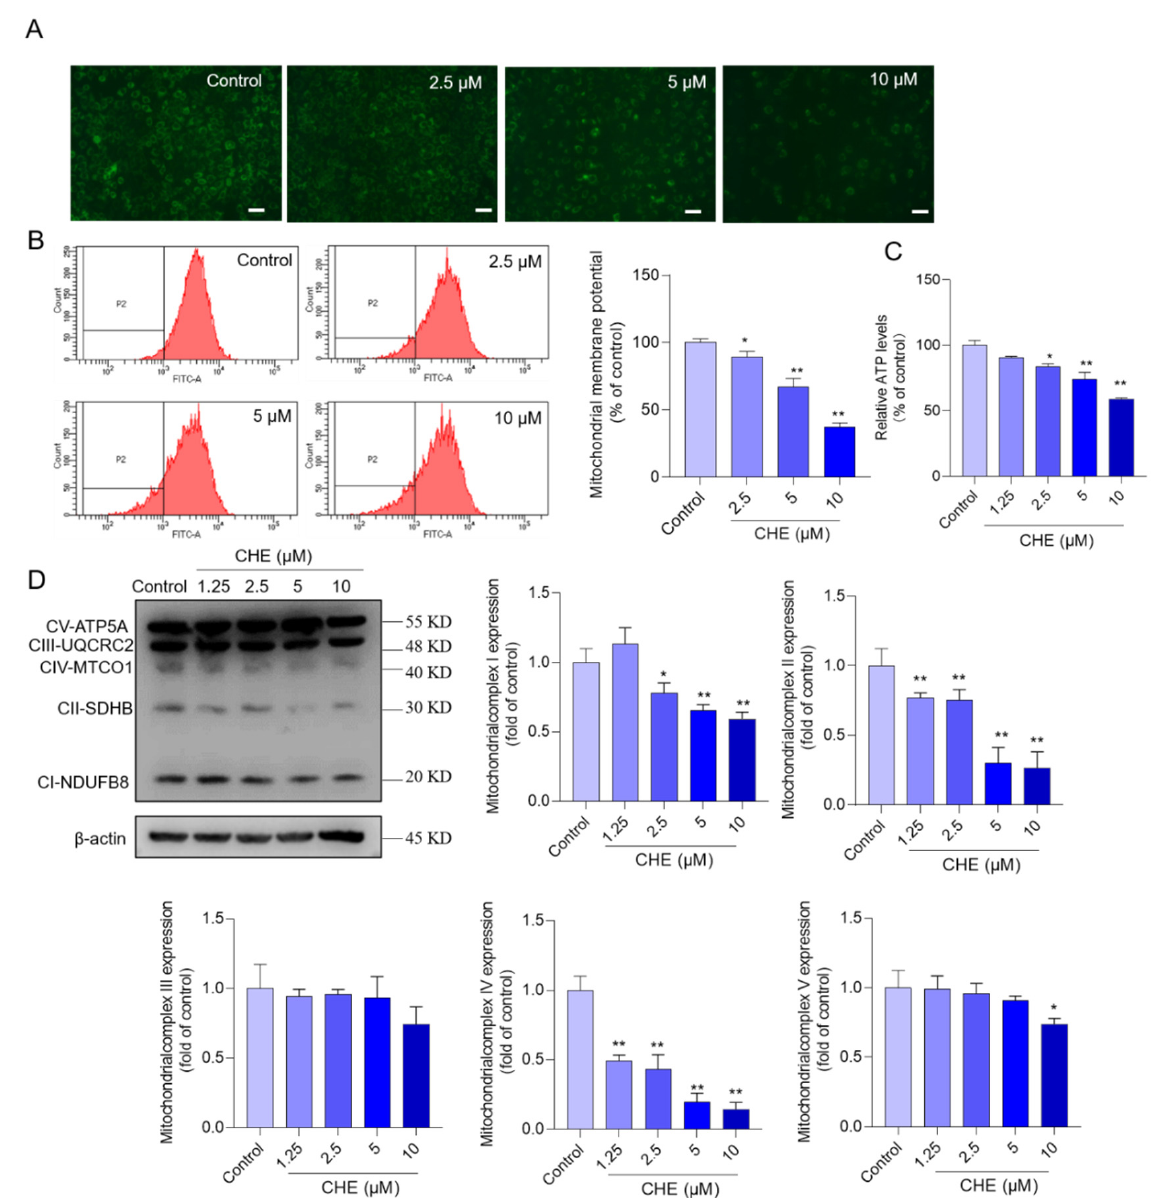
Figure 4. CHE treatment causes mitochondrial dysfunction in HepG2 cells. ( A ) the changes in mitochondrial membrane potential (MMP) were observed using a fluorescence microscope and the representative images are shown. Scale Bar = 50 µ m. ( B ) the results of flow cytometry analysis. ( C ) the levels of ATP content. ( D ) levels of expression of mitochondrial complexes I to V subunits were measured by using western blotting (on the left). The corresponding quantitative analysis was performed (on the right). Data are shown as mean ± S.D. ( n = 3). * p < 0.05, or ** p < 0.01, compared to that in the vehicle control group.